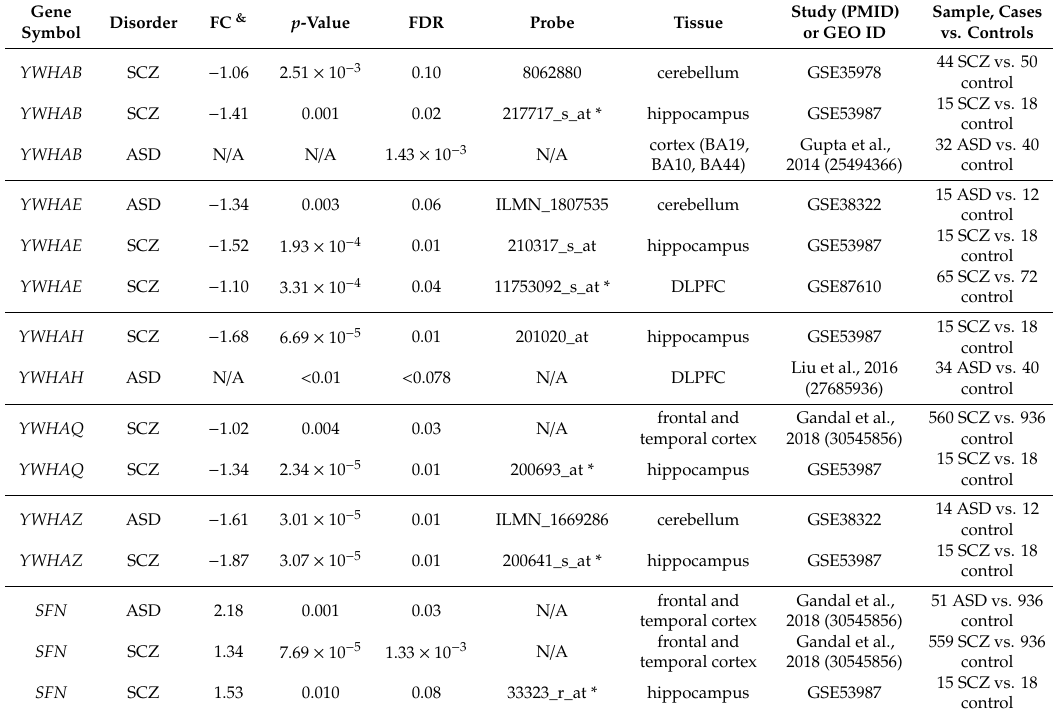
Table 3. Altered expression of the 14-3-3 genes in individuals with schizophrenia or autism spectrum